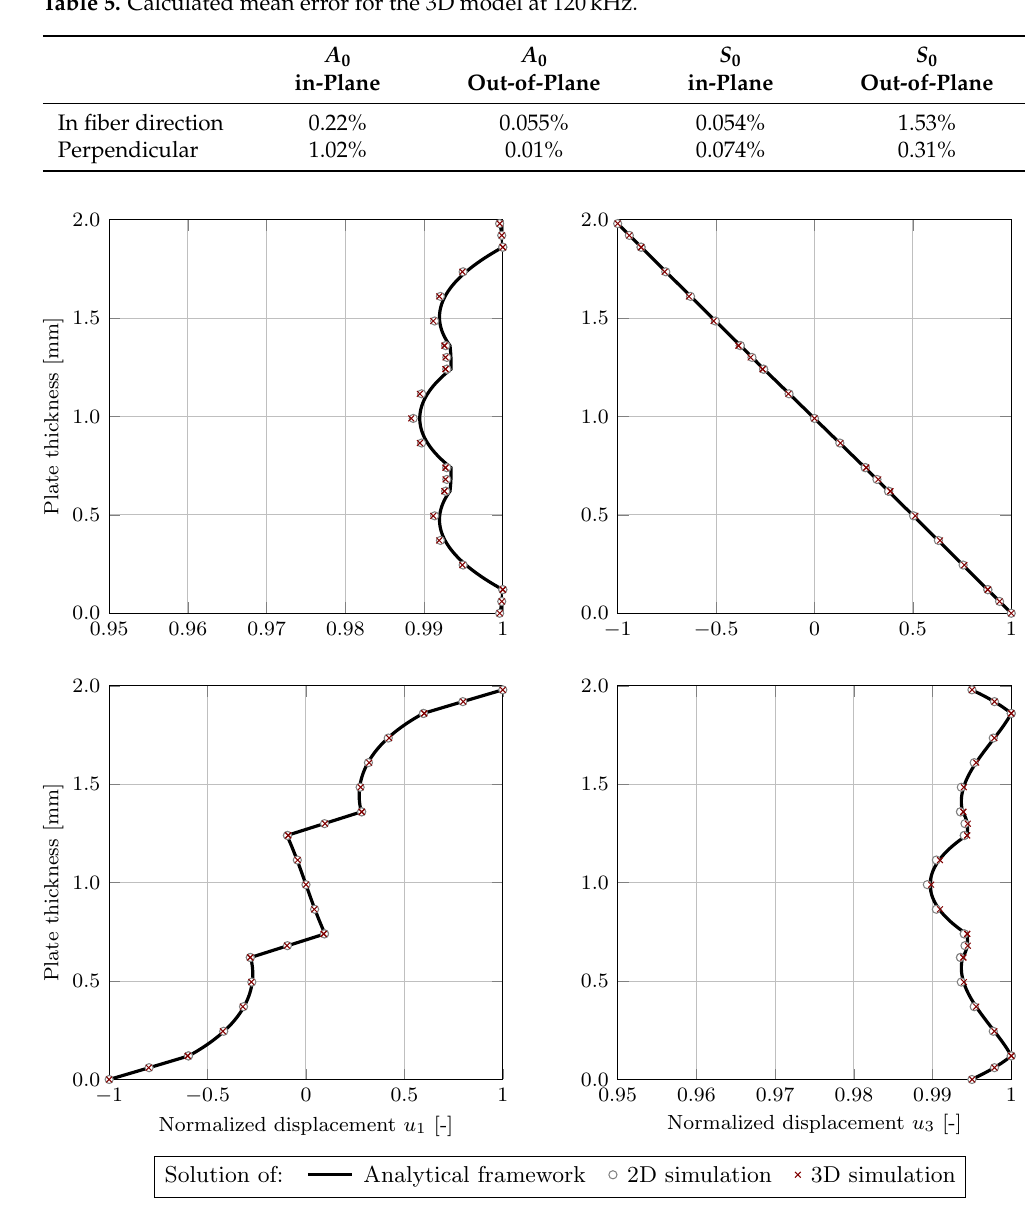
Figure 7. In-plane ( left ) and out-of-plane ( right ) components of normalized displacement field for S 0 ( top ) and A 0 ( bottom ) wave modes in the fiber orientation at 120kHz from analytical treatment and numerical 2D- and